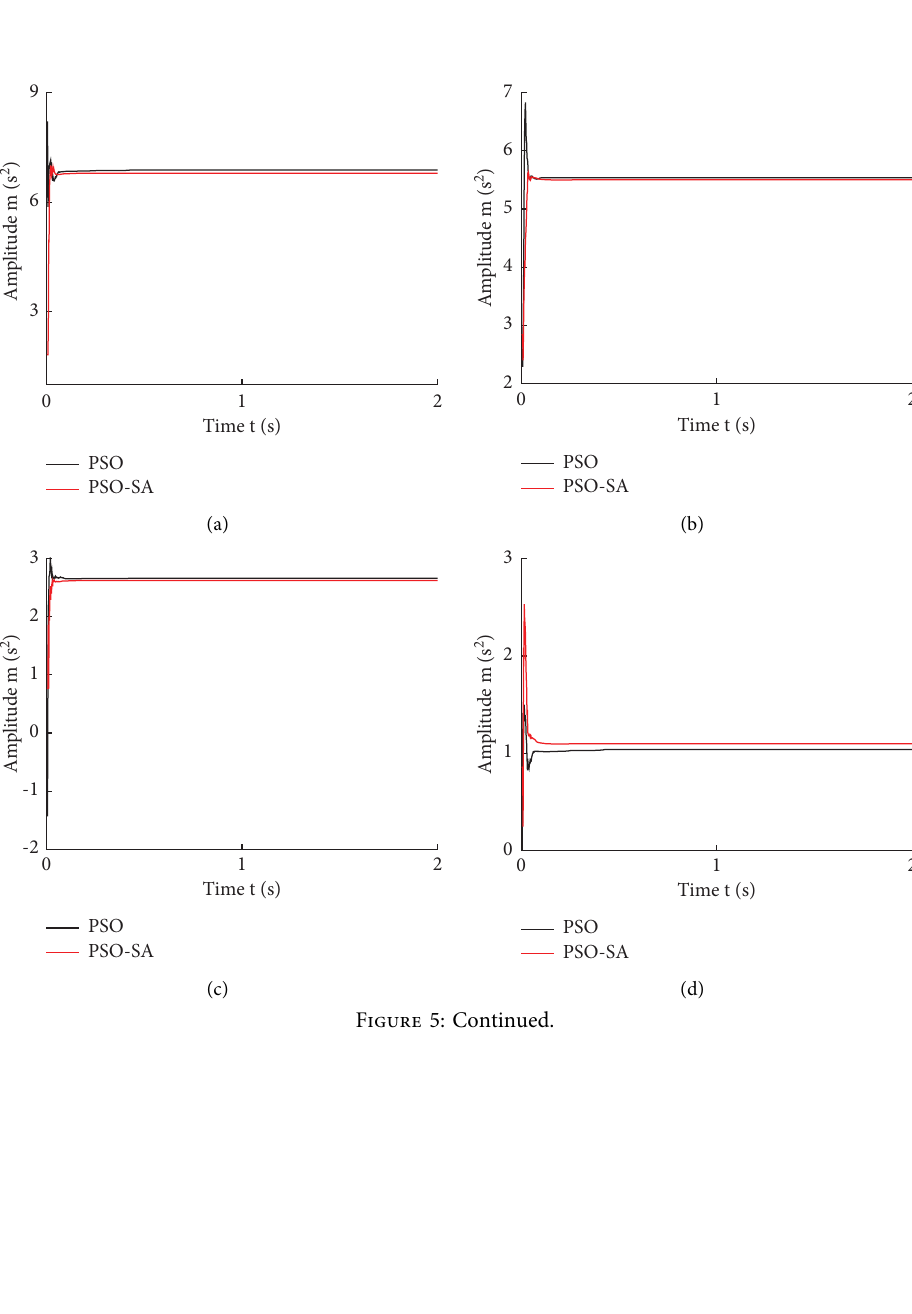
Figure 4: Control principle of the electrohydraulic servo shaker.